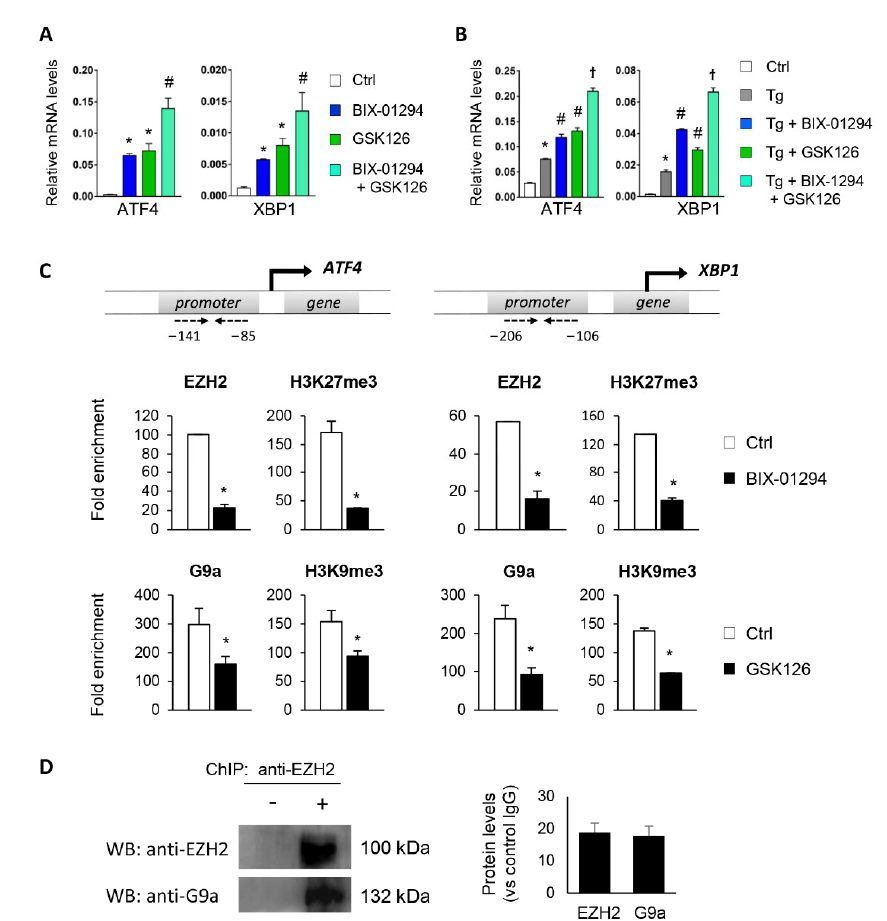
Figure 5. Interaction between G9a and EZH2 regulates ATF4 and XBP1 transcriptional repression. HK-2 cells were treated with BIX-01294 (G9a inhibitor, 15 µ M, 24 h), GSK126 (EZH2 inhibitor, 8 µ M, 24 h) or the combination of the two, in the absence ( A ) or presence ( B ) of thapsigargin (Tg, 4 µ M, 24 h). Cells treated with DMSO were used as a negative control. Gene expression levels of ATF4 and XBP1 were analyzed by quantitative RT-PCR using GAPDH as an internal control. * p < 0.05 vs. control (DMSO-treated cells); # p < 0.05 vs. Tg-induced cells; and † p < 0.05 vs. treatment with BIX-01294 or GSK126. ( C ) ChIP assay was carried out in HK-2 cells treated with BIX-01294 (15 μM, 24 h) or GSK126 (8 μM, 24 h) using specific antibodies for EZH2 or H3K9me3 and G9a and H3K27me3, respectively. Enrichment in the promoter region of ATF4 and XBP1 genes was determined by quantitative RT-PCR using specific primers (dashed arrows). * p < 0.05 vs. control. ( D ) ChIP assay in untreated HK-2 cells with anti-EZH2 antibody and further Western blotting with EZH2 and G9a antibodies. Data are shown as the mean ± SEM of two independent experiments.